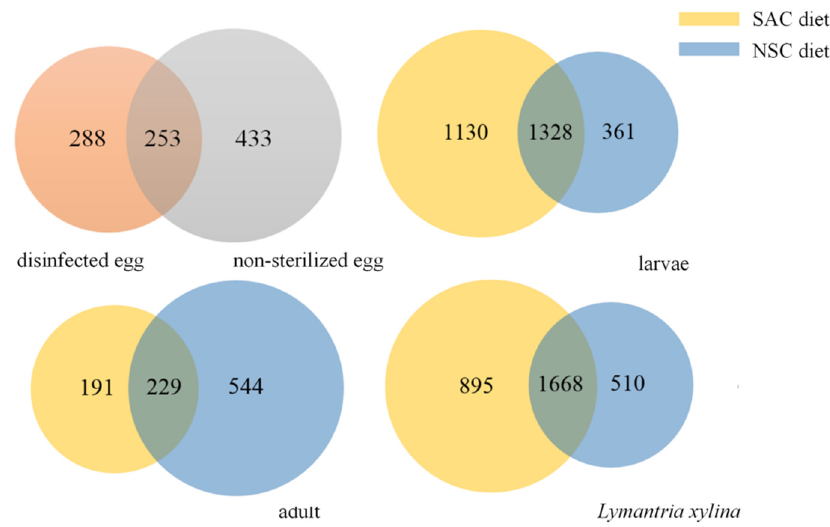
Figure 1. OTUs of egg and gut microbiota of L. xylina fed on SAC and NSC. SAC represents L. xylina fed on a sterilized artificial diet mainly composed of a C. equisetifolia branch, while NSC represents L. xylina fed on a diet of non-sterilized C. equisetifolia branch.